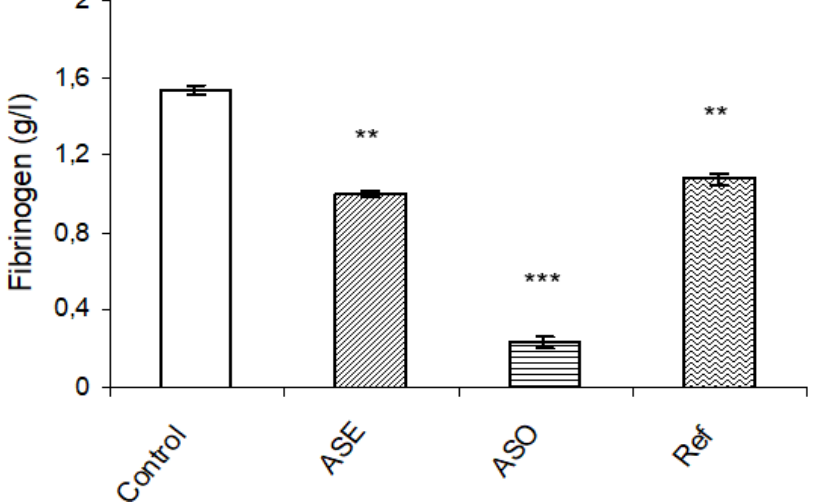
Figure 3. Effects of Allium subhirsutum L. extract (ASE), Allium subhirsutum L. oil and the reference drug “Cytolcentella ® ” on fibrinogen level. Data represent the mean ± SEM for six rats. Statistically significant variations are compared as follows: ASE, ASO and Ref treated groups compared to control group: ** and *** indicate significant differences when p < 0.01 and p < 0.001, respectively.